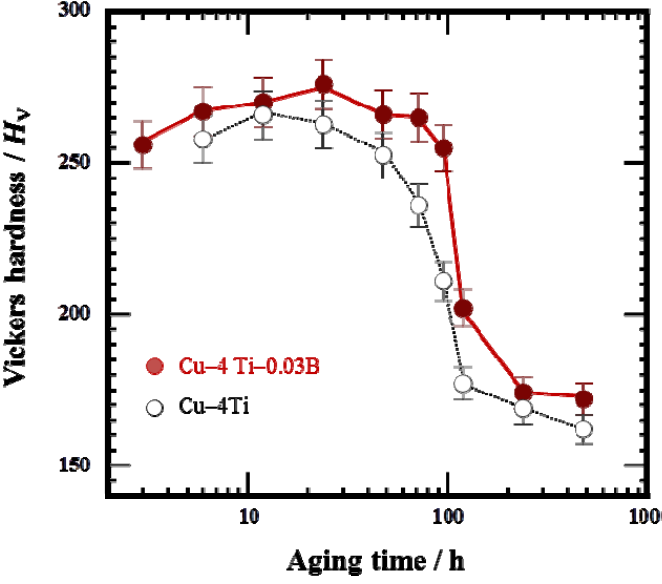
Figure 4. Vickers hardness of Cu–4Ti–0.03B and Cu–4Ti alloys that were aged at 450